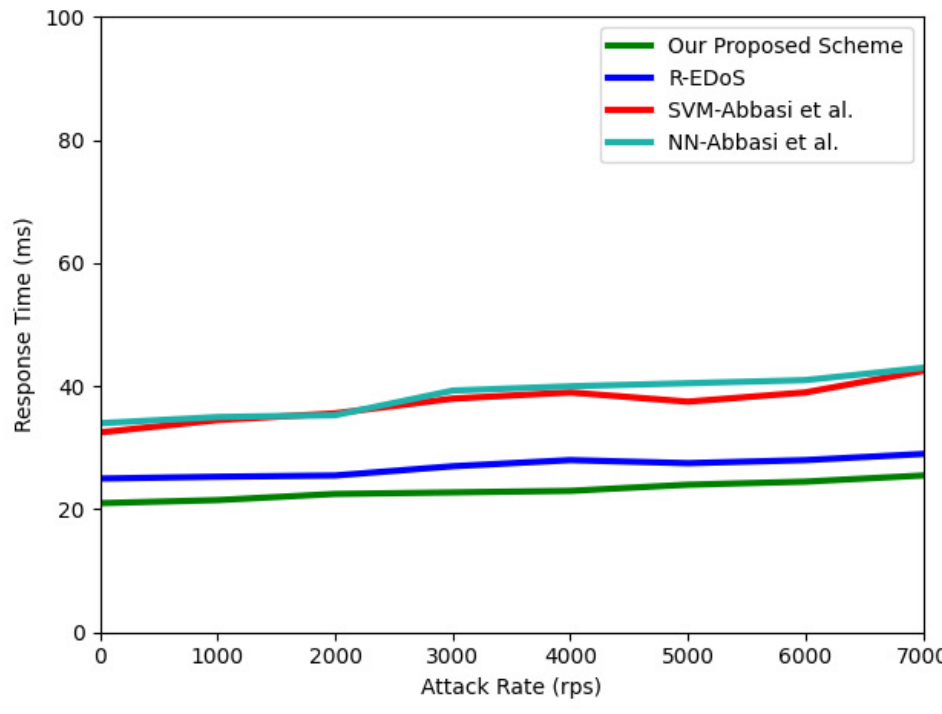
Figure 11. Response time among four